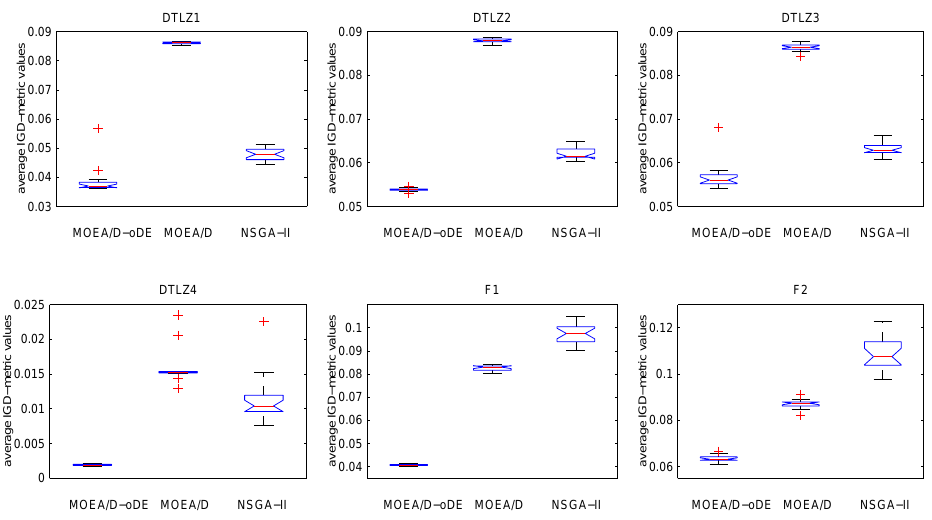
Figure 6. Box plots of the IGD metric values based on 20 independent runs for four-objective test